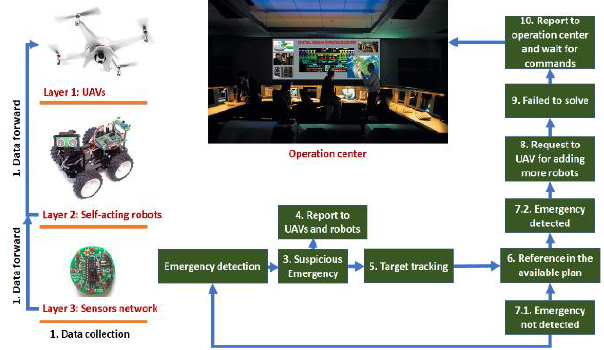
Figure 101. Processes information and operation of the measurement points in the sensor network